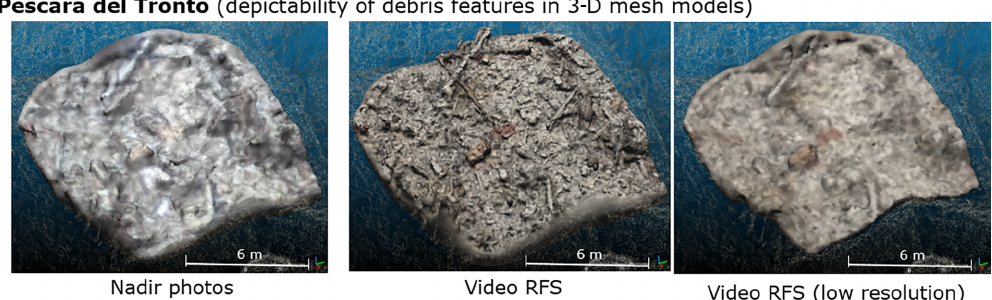
Figure 9. Comparison of the depictability of debris features in photo- and video-based mesh models of Pescara del Tronto. Lower depictabil- ity in nadir-photo-based mesh due to their high GSD and the presence of motion-blur effects.